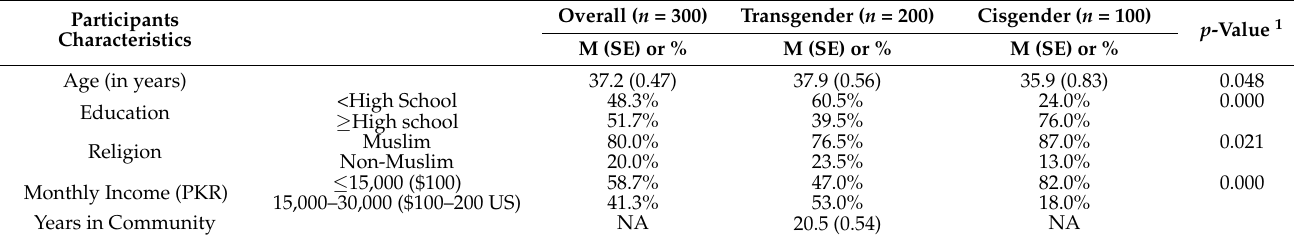
Table 1. Means ( ± SE) and percentages (for categorical variables) of the demographic characteristics of sample ( N = 300) and transgender and cisgender subsamples.